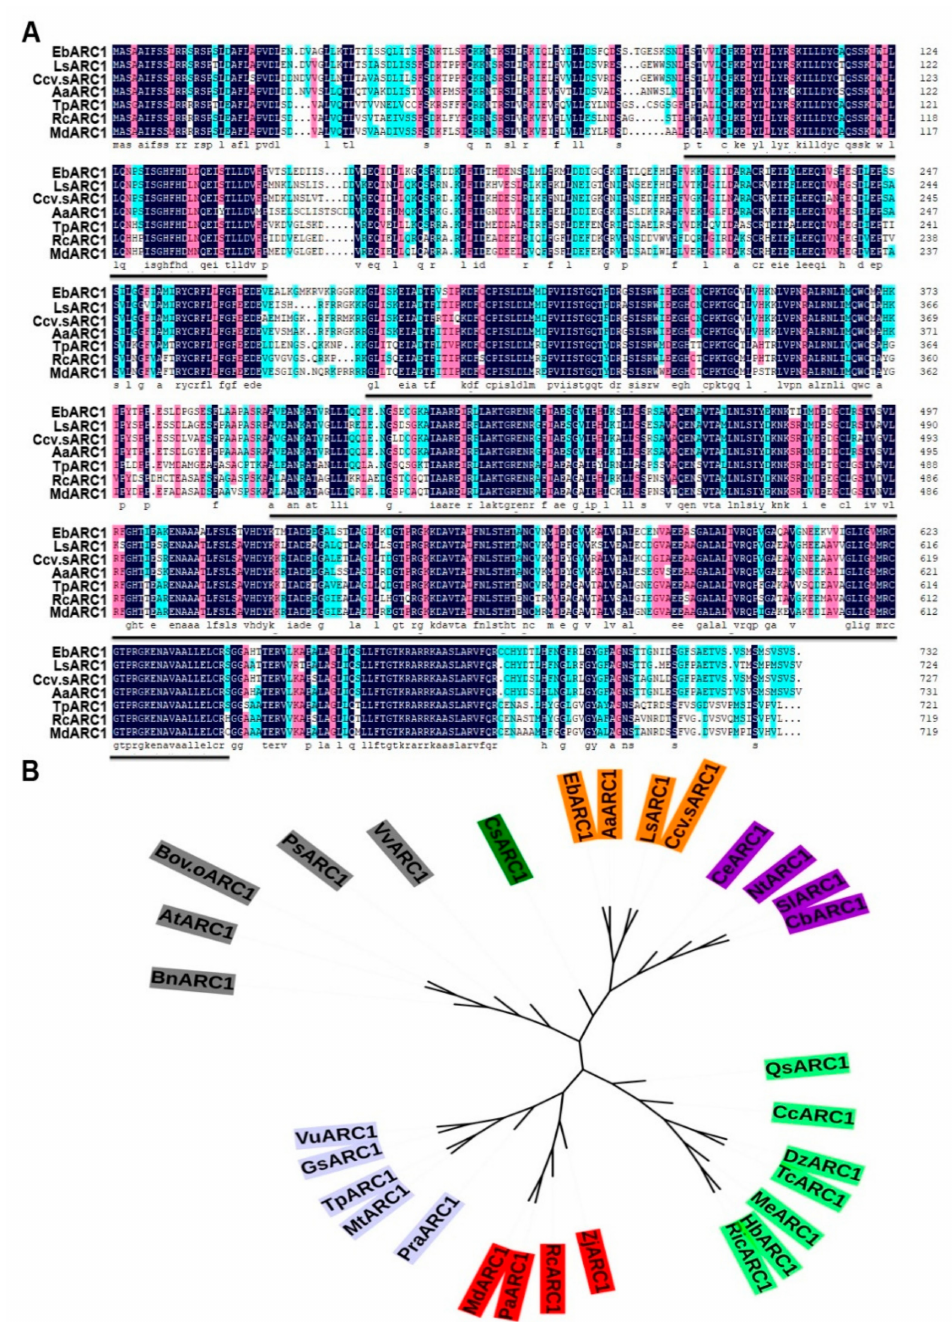
Figure 2. Sequence analysis of EbARC1. ( A ) Alignment of the amino acid sequences of EbARC1 and orthologous proteins from other plant species, including Lactuca sativa L. var. ramosa Hort. (XP_023732862.1), Cynara cardunculus var. scolymus L. (XP_024992831.), Artemisia annua L. (PWA78229.1), Trifolium pretense L. (PNX95847.19), Rosa chinensis Jacq. (XP_024199500.1), and Malus domestica L. (XP_008371510.2). Identical residues are shown on a black background. Blue and black lines point to the conserved domains of the U-box and ARM repeat domains, respectively. ( B ) Phylogenetic tree of EbARC1 and ARC1s from other plant species, including Arabidopsis thaliana L. (AtARC1, NP_195803.1), L. sativa (LsARC1, XP_023732862.1), A. annua (AaARC1, PWA78229.1), C. cardunculus (Ccv.sARC1, XP_024992831.), Nicotiana tabacum L. (NtARC1, NP_001313174.1), Solanum lycopersicum L. (SlARC1, XP_004233034.1), Hevea brasiliensis L. (HbARC1, XP_021659773.1). Durio zibethinus Murr. (DzARC1, XP_022720359.1), Medicago truncatula Gaertn. (MtARC1, XP_003593822.2), Theobroma cacao L. (TcARC1, EOY27921.1), Prosopis alba Grisebach. (PaARC1, XP_028770127.1), Co ff ea eugenioides S.